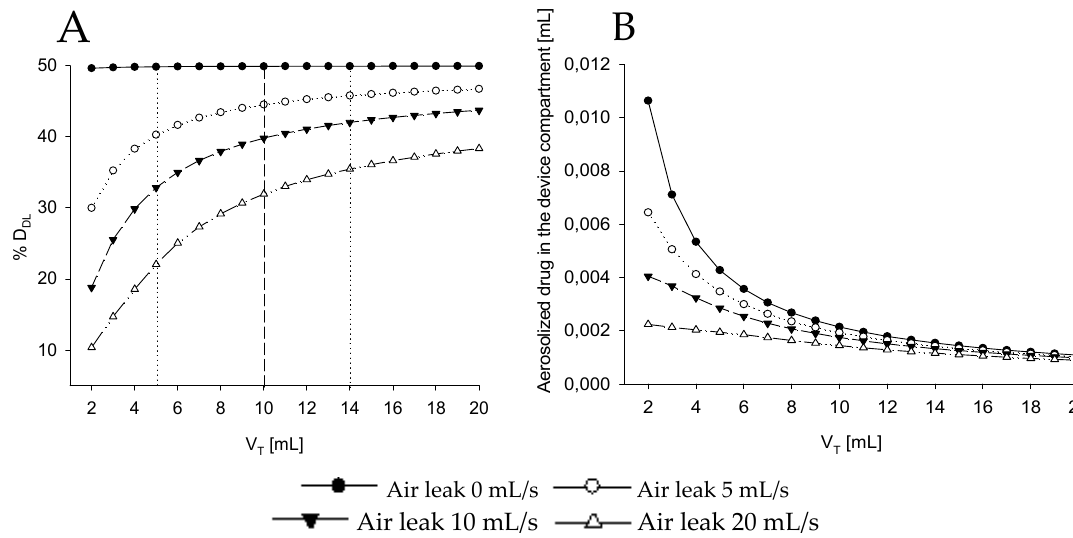
Figure 3. ( A ) Percentage of the drug delivered to the lung (%D DL ) with respect to the total drug aerosolized over multiple tidal volumes (V T ). ( B ) Averaged amount of aerosolized drug in the device compartment in case upper airways volume compartment has been neglected. Each line refers to a di ff erent air leak from 0 mL / s to 20 mL / s. Dotted lines at V T equal to 5 and 14 mL highlight, respectively, the response of the system when two babies representing the upper and lower limit of the patient population are considered. The dashed line emphasized the response of the system at tidal volume smaller (left) or bigger (right) than the dead space of the nebulizer. V T = tidal volume, D DL = drug delivered to the lung.